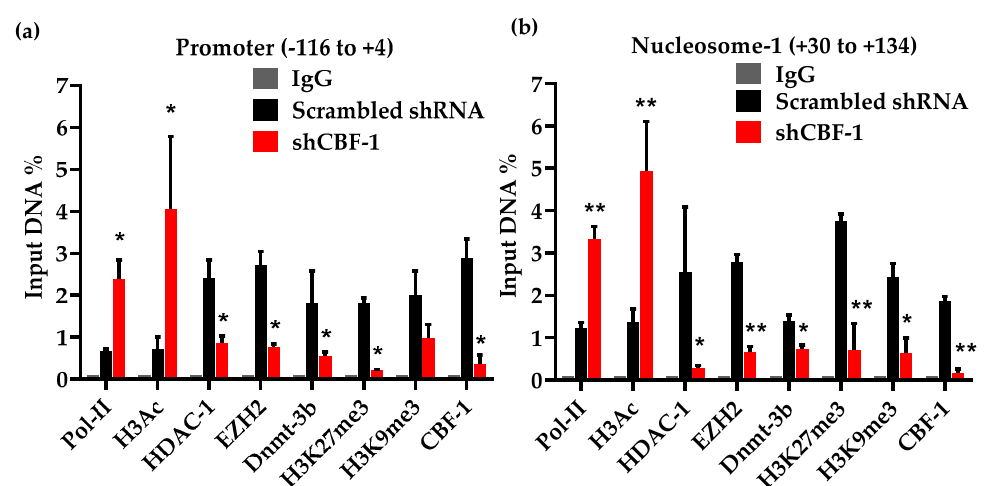
Figure 3. CBF-1 restricts HIV transcription by inducing multiple types of repressive epigenetic modifications at HIV LTR. Chromatin immunoprecipitation (ChIP) analyses were performed using latently infected Jurkat T cells to evaluate the turnover of different epigenetic modifications at HIV LTR in the absence or presence of knockdown of endogenous CBF-1, using the indicated antibodies. Primer sets directed to the ( a ) Promoter region ( − 116 to +4) with respect to transcription start site; ( b ) Nucleosome 1 (+30 to +134) with respect to transcription start site of HIV-1 LTR. The depicted ChIP assay results were reproduced 5 times. Graphs represent the average and standard deviation from three independent and replicate samples. Statistical analysis was calculated with GraphPad Prism 5.0 (GraphPad Software, San Diego, CA, USA). The p value of statistical significance was set at either; p < 0.05 (*) or 0.01 (**).